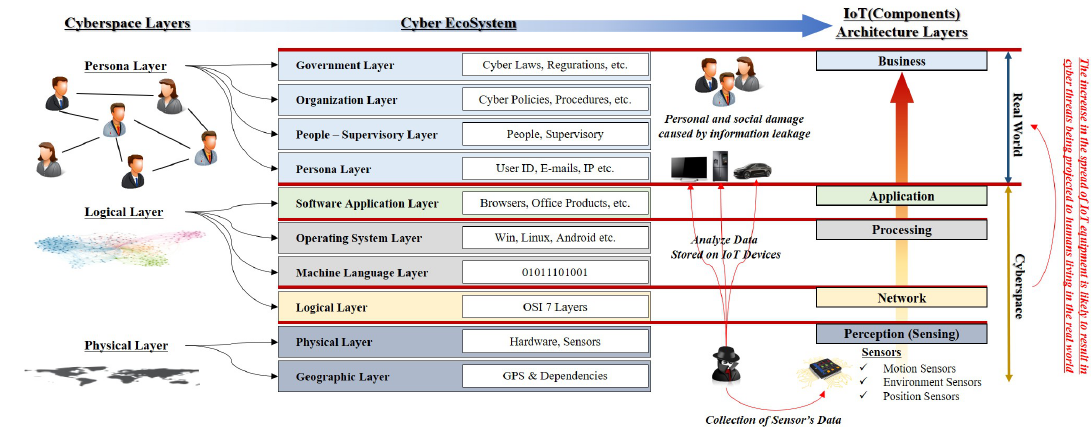
Figure 1. Owing to developments in technology, cyberspace has become connected to real world and the result of threat in cyberspace can be extended to real